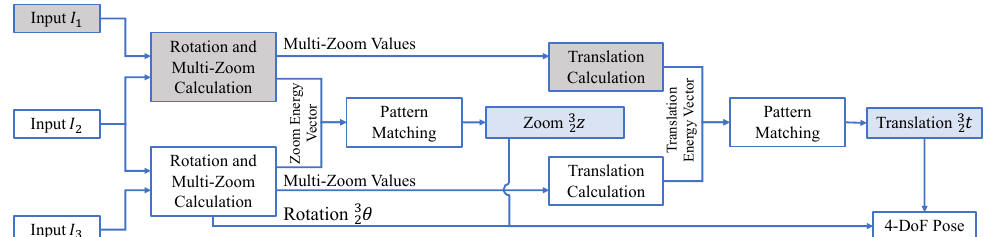
Figure 4. Pipeline of eFMT. Please note that the output is the 4DoF transformation between frame I 2 and I 3 , but using 3 frames to estimate the re-scaling factor. The gray boxes indicate that the computation results of the previous iteration are